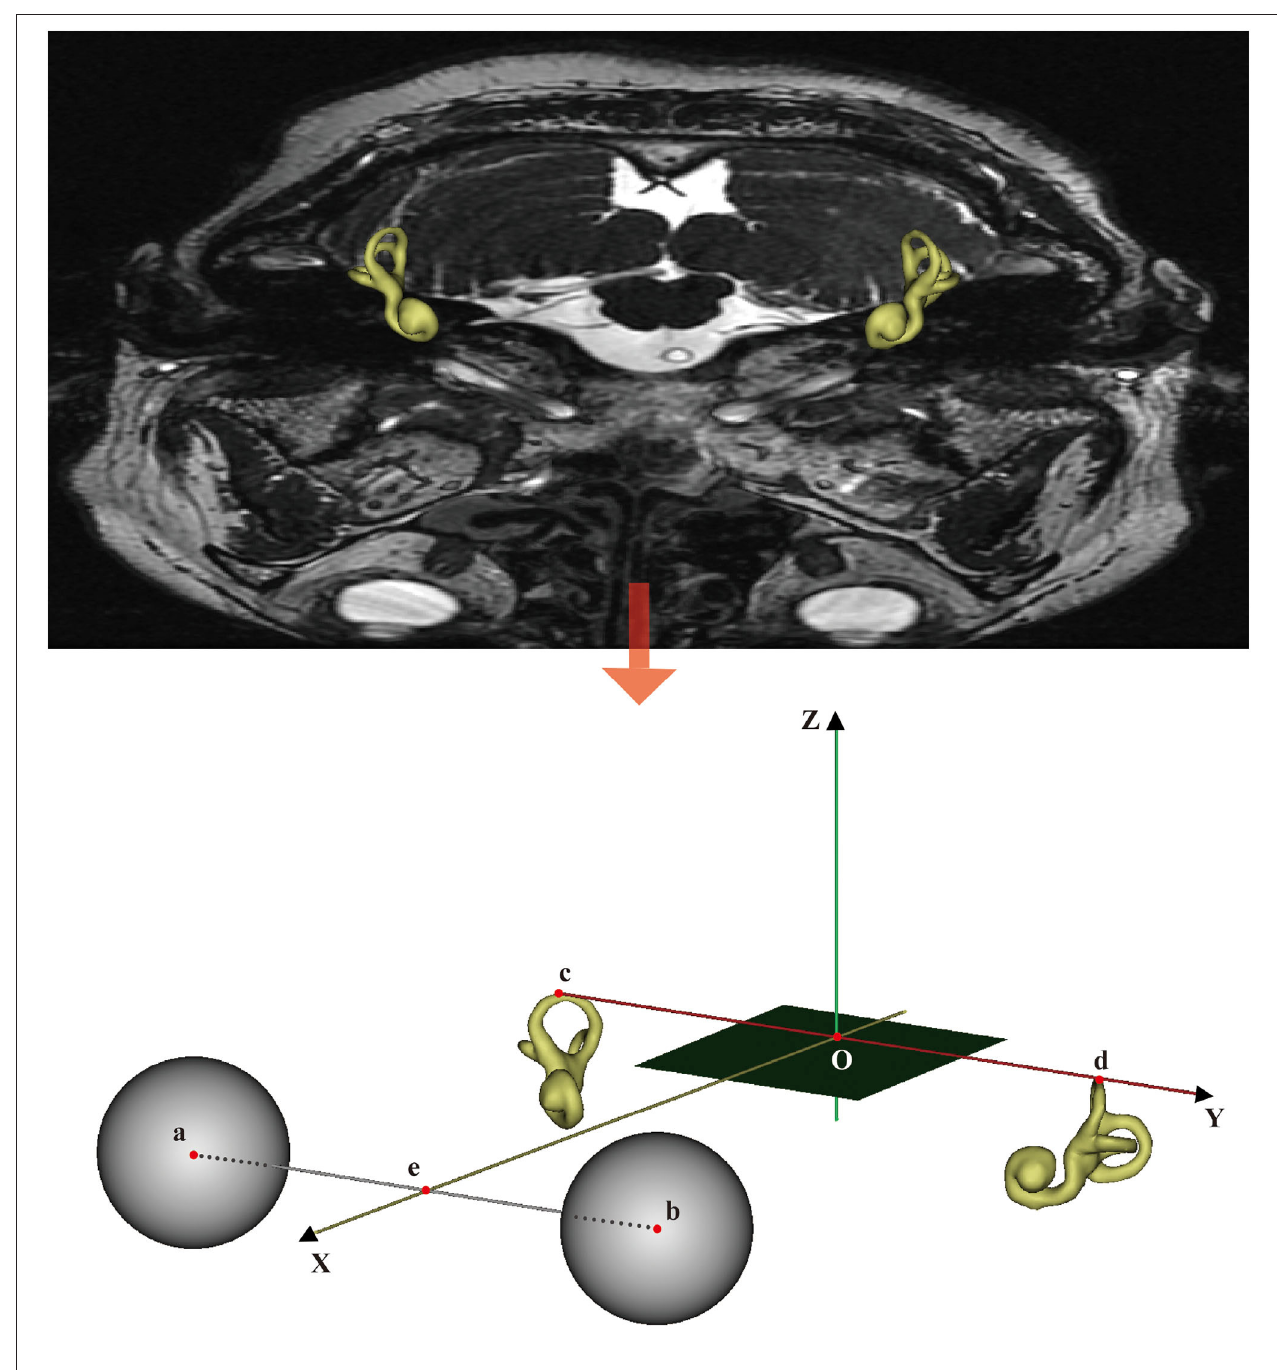
FIGURE 2 | The W–X coordinate system overlaid on a CT image. Points a and b are the centers of the two eyeballs. Points c and d are the vertices of the bilateral superior semicircular canals. Point e is the midpoint of the line segment ab. The origin of the coordinate system, point O, is the midpoint of line segment cd. The x- −→ −→ and y -axes are defined by the rays Oe and Od, respectively, and the z -axis is normal to the horizontal plane containing x and y ( + superior). The SP is defined as the plane that contains point O and is perpendicular to the y -axis.